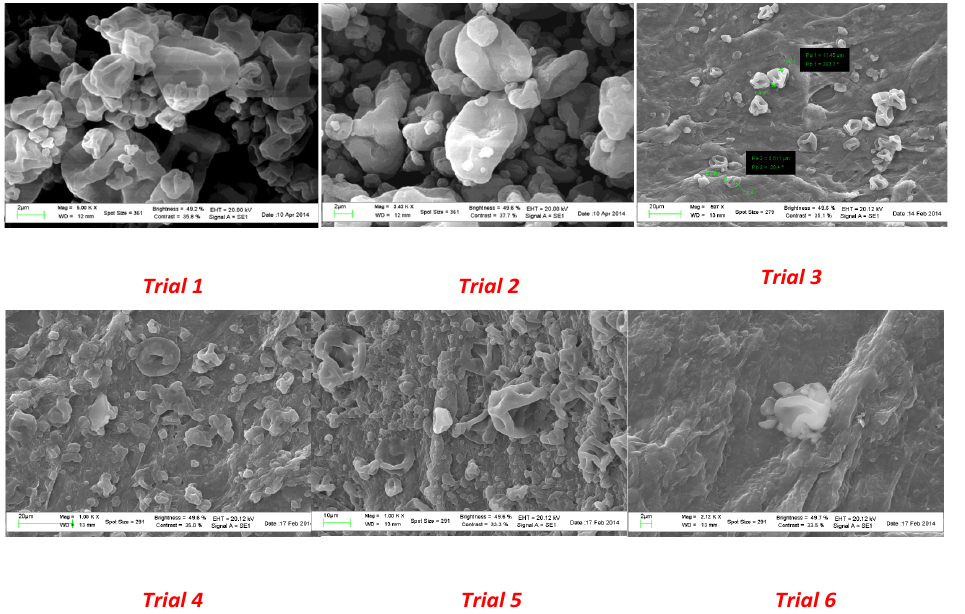
Figure 4. SEM images of microparticles from spray drying experiments after 2 h in an aqueous en- vironment.